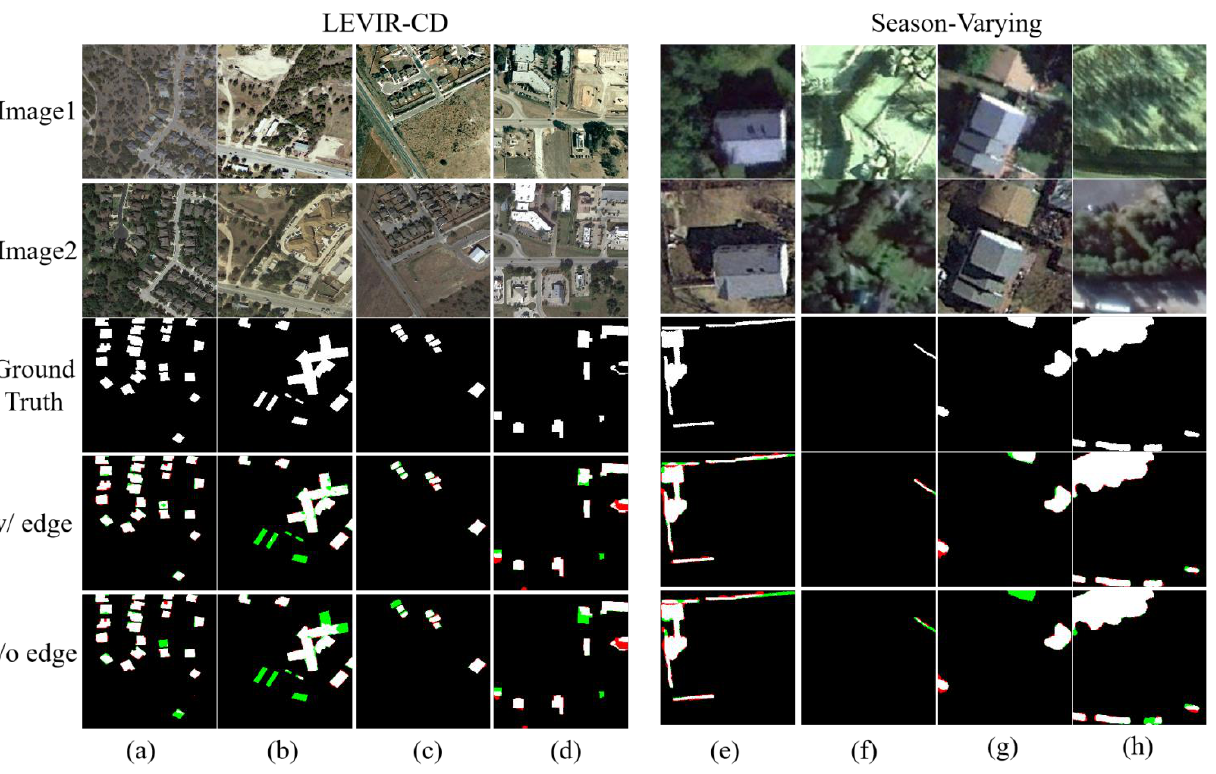
Figure 8. Effects of edge-information feature-enhancement module. Different colors are used for a better view, i.e., white for true positive, black for true negative, red for false positive, and green for false negative. ( a – d ) are in the LEVIR-CD dataset. ( e – h ) are in the season-varying dataset. Table 6. Effects of edge-information feature-enhancement module.